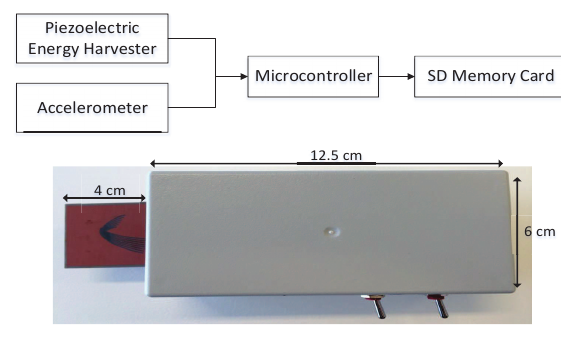
Figure 2: The hardware